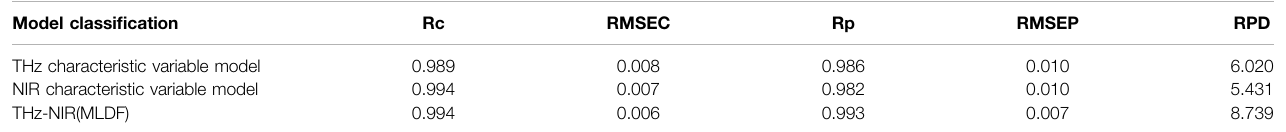
TABLE 3 | Comparison of model evaluation indexes.